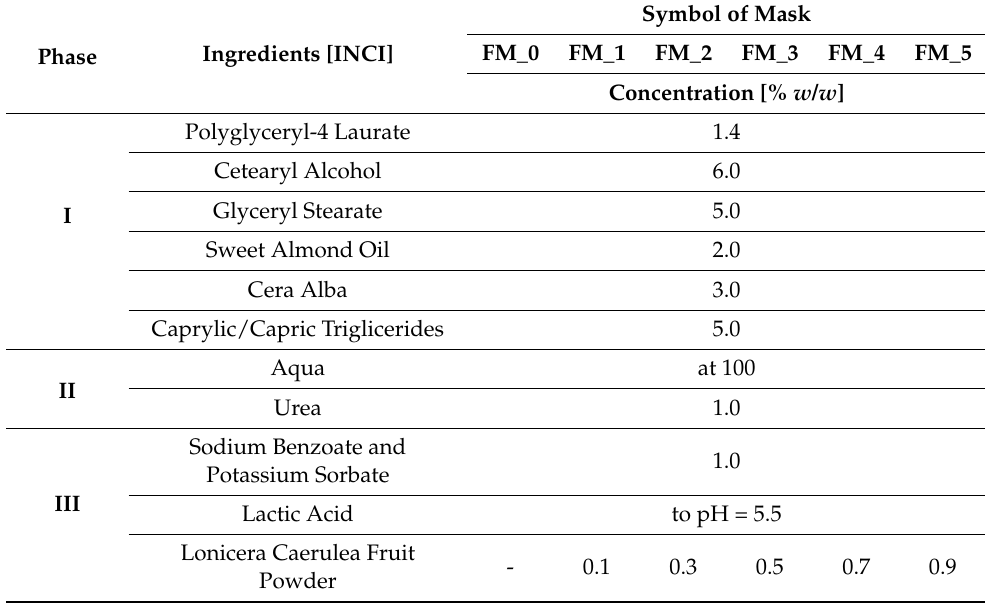
Figure 6. Cosmetic masks containing varying concentrations of blue honeysuckle powder. Table 4. Formulations of cosmetic face masks with varying concentrations of blue honeysuckle pow- der.